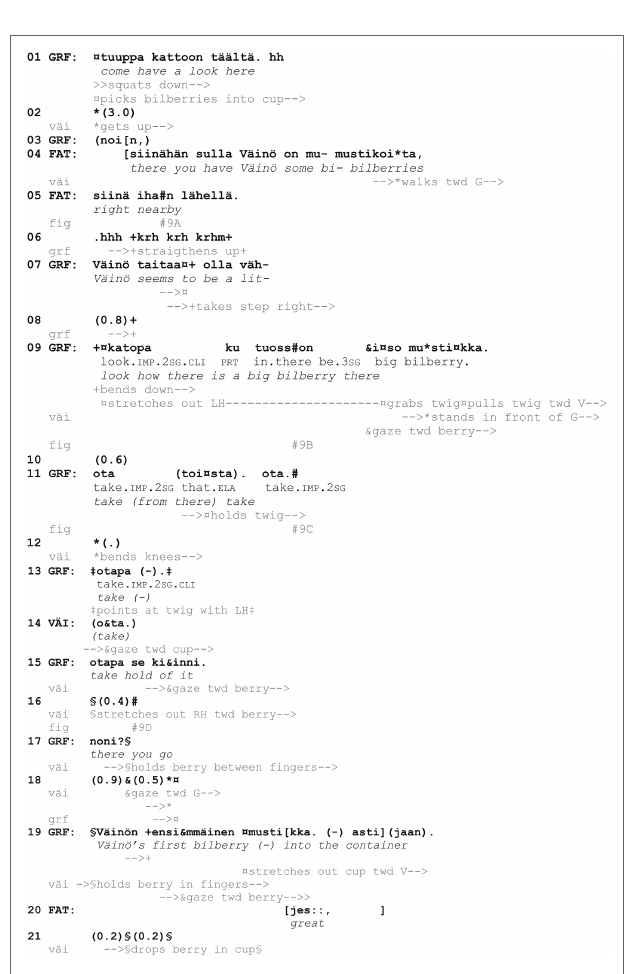
EXAMPLE 9 | 22HANS Mustikassa II